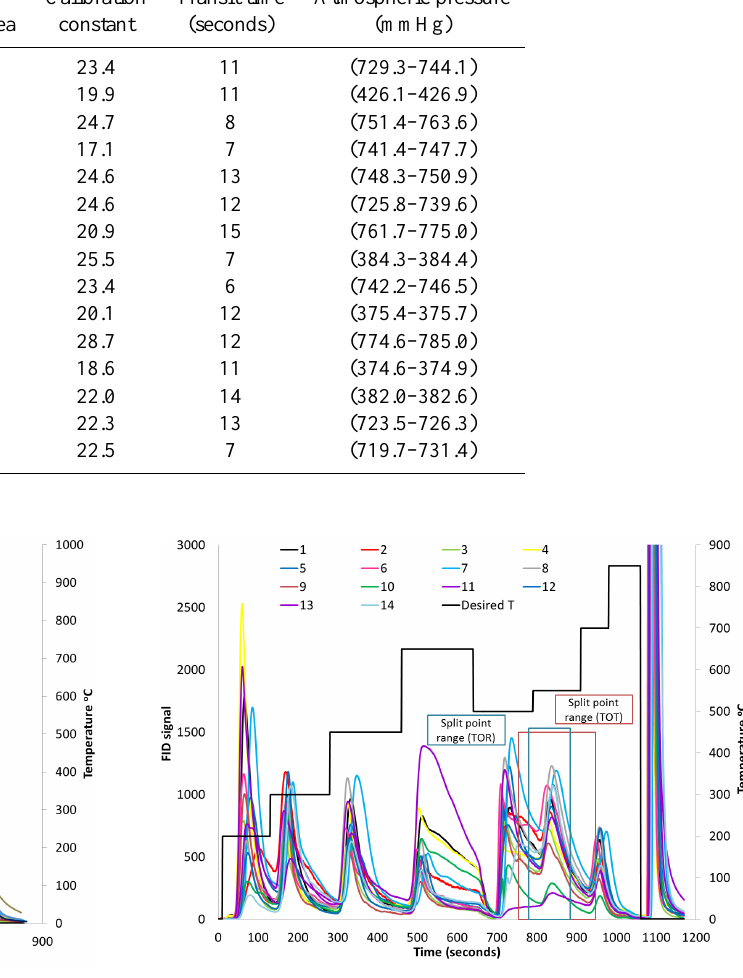
Figure 3. Thermograms of ECOC analysis on PM loaded quartz fibre filter (A sample), by EUSAAR2 for all participants.